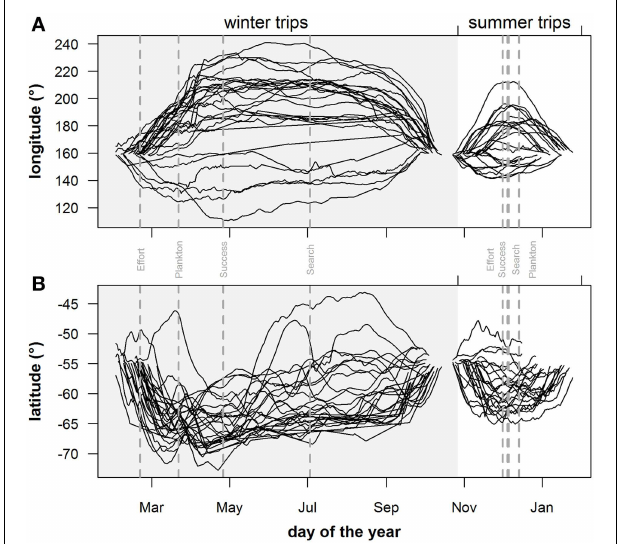
FIGURE 6 | Geographical extent of individuals: seasonal trends of (A) longitude and (B) latitude position of individual seals during the summer (non-shaded area) and winter (shaded area) foraging trips. Gray vertical dashed lines in plots indicate peak values for plankton densities (Plankton), foraging behavior (Search), dive effort (Effort) and foraging success